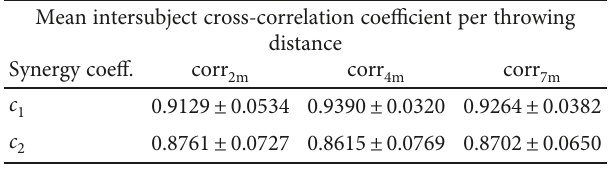
Table 4: Synergy coe ffi cients mean intersubject cross-correlation coe ffi cient per throwing distance. Mean intersubject cross-correlation coe ffi cient per